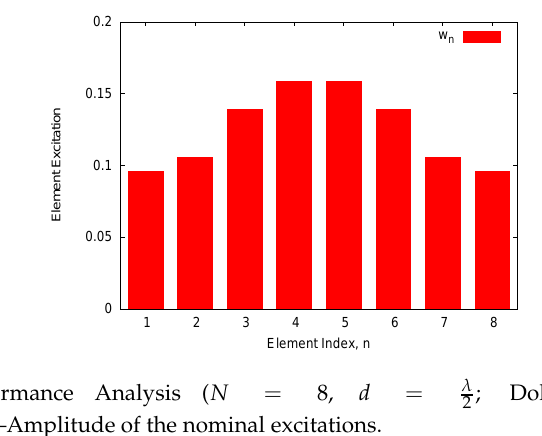
; Dolph–Chebyshev pattern: 2